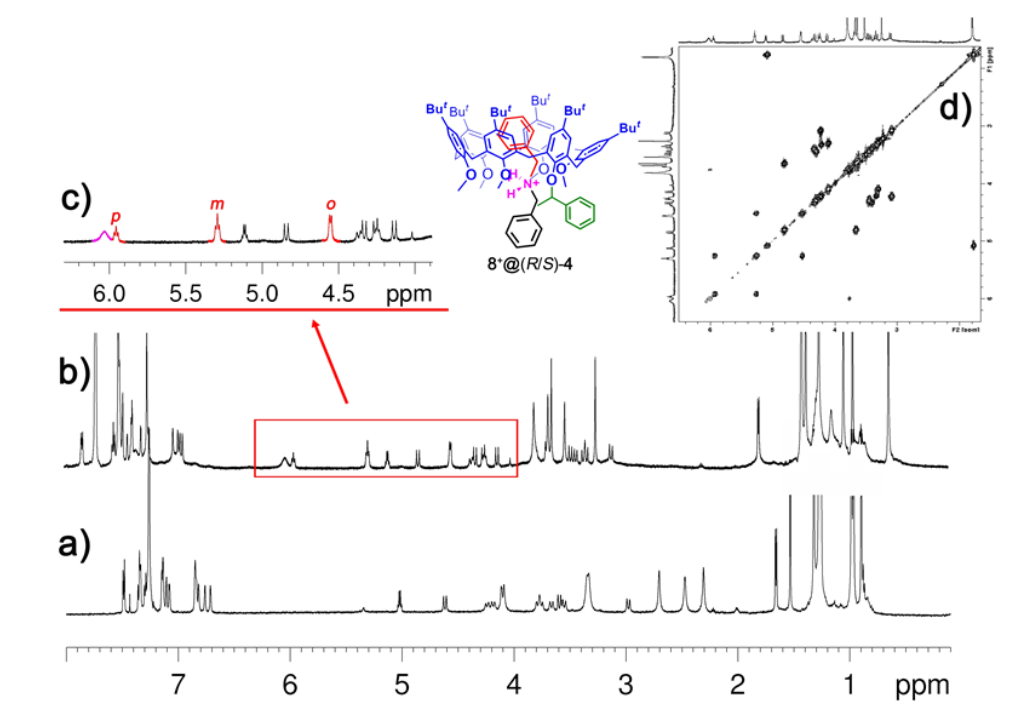
Figure 3. Significant portions of the 1 H NMR spectra (600 MHz, CDCl 3 , 298 K) of: ( a ) ( R/S )- 4 ; ( b ) 1:1 mixture (3 mM) of ( R/S )- 4 and 8 + ∙B(Ar F ) 4 − after mixing. Insets: ( c ) expansion of the 1 H NMR and ( d )